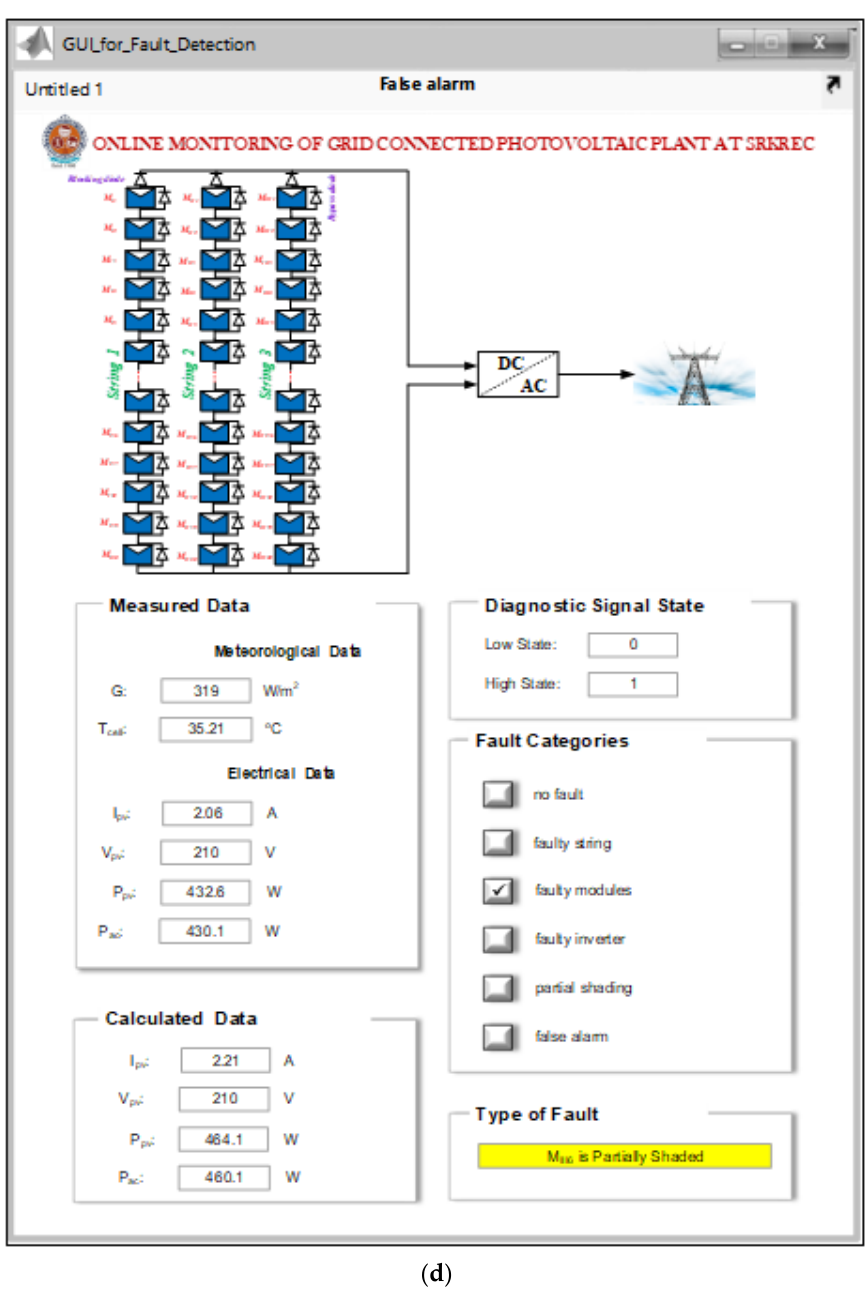
Figure 13. ( a ) Evolution of diagnostic signal during partial shading condition; ( b ) measured PV current; ( c ) measured PV current; ( d ) faulty module observed in designed tool.